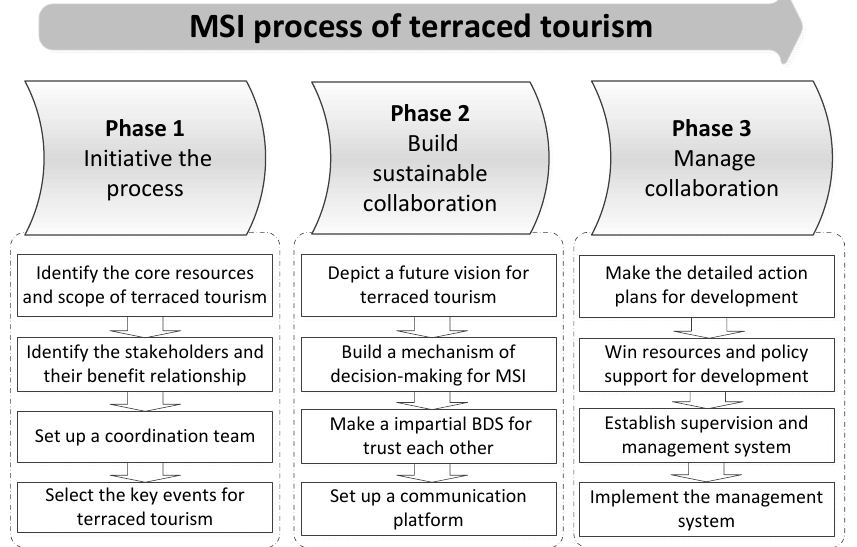
Figure 4. the route of exploring MSIM and its construction. Figure 4. The route of exploring MSIM and its